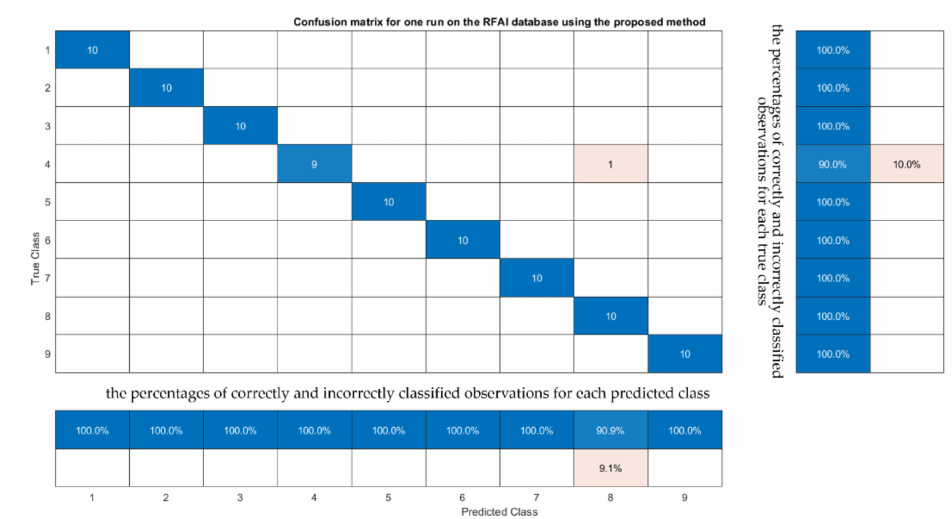
Figure 14. The confusion matrix obtained by using the proposed method for a random